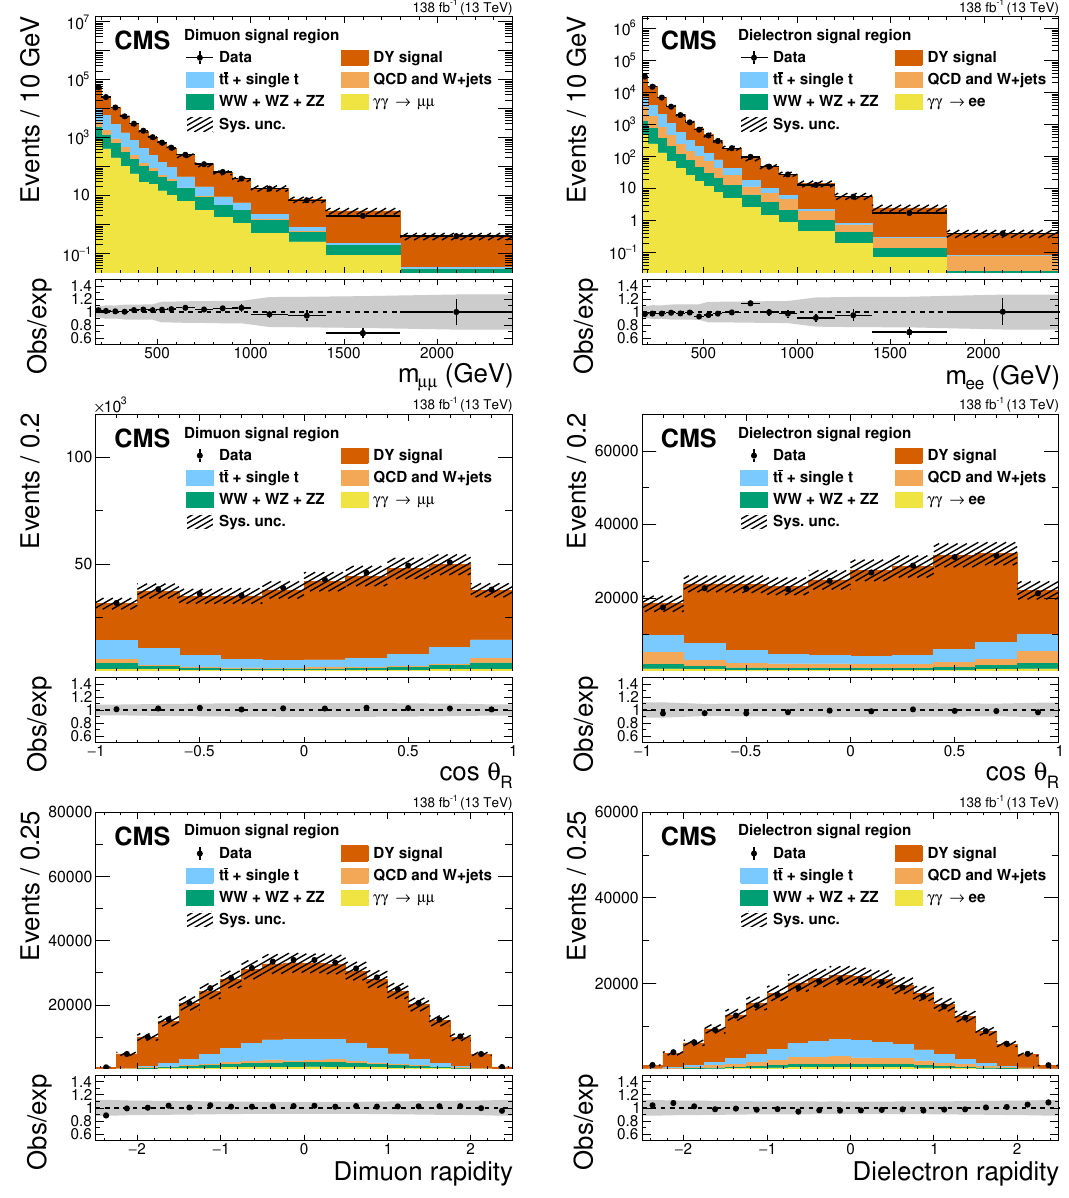
Figure 2 . A comparison of CMS data and expected signal and background distributions in dilepton invariant mass (upper row), cos θ (middle row) and dilepton rapidity (lower row). The R left plot shows the mm channel and the right plot the ee channel. The black points with error bars represent the data and their statistical uncertainties, whereas the combined signal and background expectation is shown as stacked histograms. The hatched band shows the systematic uncertainty in the expected signal and background yield. The sources of this uncertainty are discussed in section 8. The lower panels show the ratio of the data to the expectation. The gray bands represents the total uncertainty in the predicted